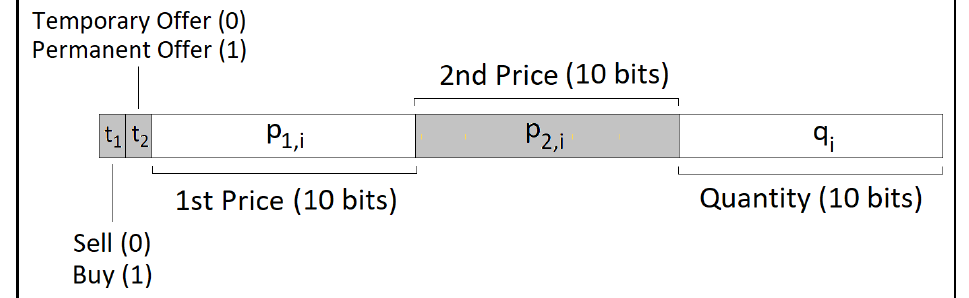
Figure 2. Bits of a bid string in terms of the bid content: The length of 32 bits comprises in this order t 1 , t 2 , p 1, i , p 2, i , and q i